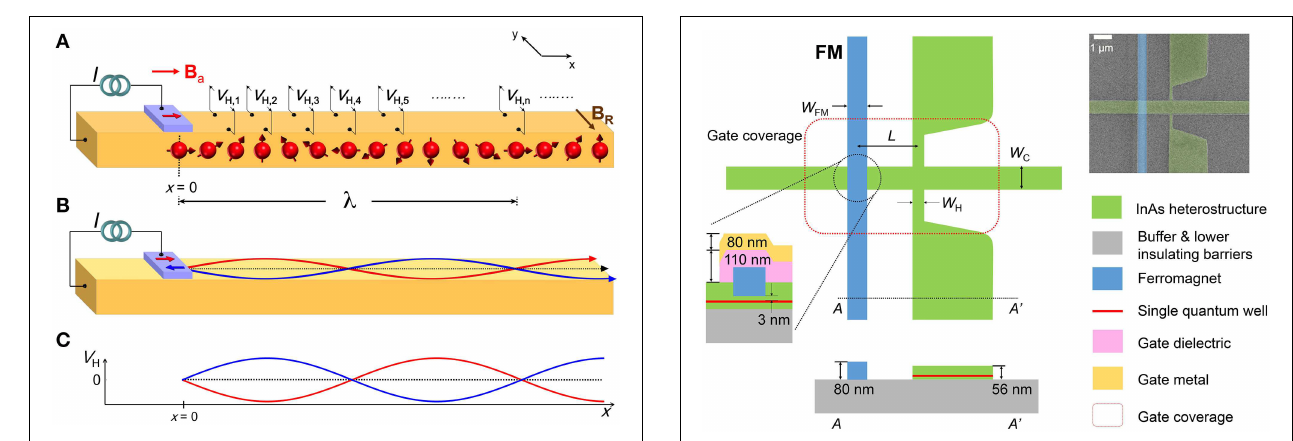
FIGURE 7 | (A) Applied field B a controls the magnetization orientation of the FIGURE 8 | “Schematic top and cross-section views of geometry of ferromagnetic injector along x (red arrow on FM). Red spheres represent spin each individual device. The single quantum well channel and Hall cross are +ˆ polarized electrons injected at x 0 . As described in Figure 3B , these carriers formed by subtractive processing using electron beam lithography and an Ar = move in the nonlocal region with spin precession. A series of Hall detectors, ion mill. The FM electrode is deposited after a portion of the top barrier of the V H , i , is arrayed along the channel in the region x > 0 . (B) “Deflection of ballistic InAs heterostructure is etched. w H 200 nm, w FM 400 nm. Distance L is = = trajectories caused by the intrinsic spin Hall effect. dotted line: trajectory with measured center-to-center. A single sample is fabricated with dielectric and no deflection. red: trajectory for magnetization along x . blue: trajectory for gate layers that cover the entire device region.” This sample is discussed in + magnetization along x (blue arrow on FM). (C) Hall voltage in region x > 0 as Section 3.4. Inset: Scanning electron micrograph of a device with w C 750 − = a result of inverse spin Hall effect.” In (A) , a set of Hall cross detector at nm, L 1 . 32 µ m. Figure and portion of caption reproduced from Choi et al. = discrete distances x L i determine the phase of the spin of the ballistic [ = electron because E S ( L i ) is proportional to the local spin Hall voltage, V SH . Figure and portion of caption reproduced from Choi et al. [ 23].